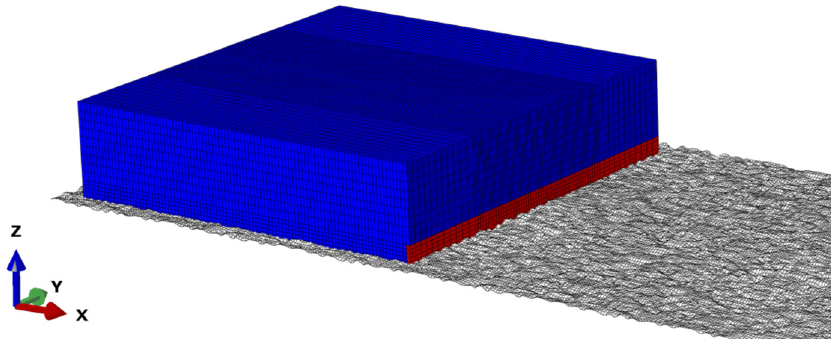
Figure 16. Initial state of tire aquaplane.